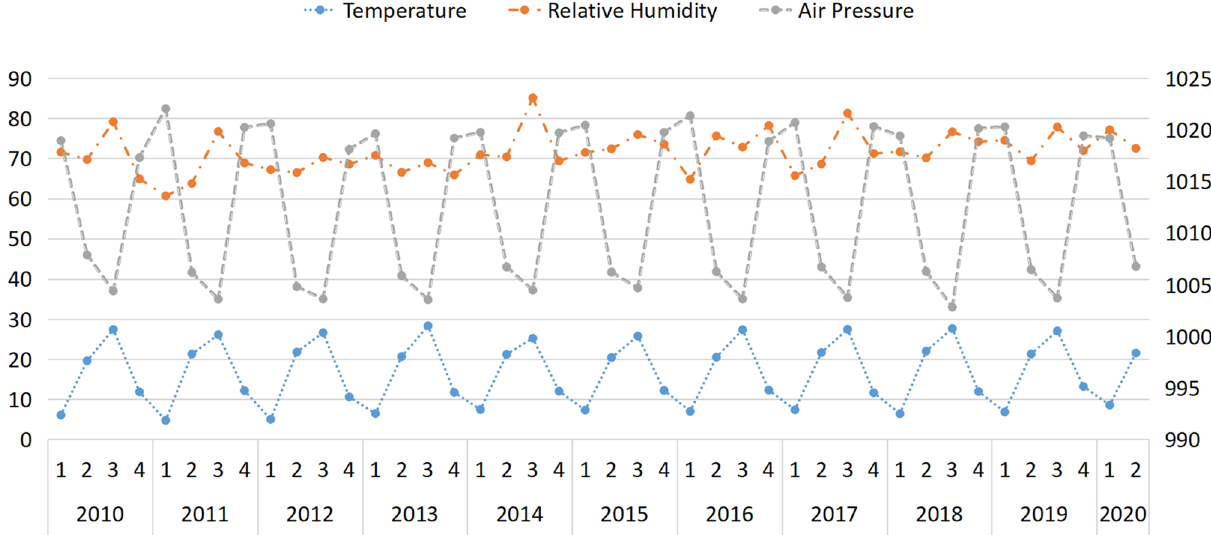
Figure 1. Trends in climatic factors according to quarter over the 10-year study period (2010–2020).